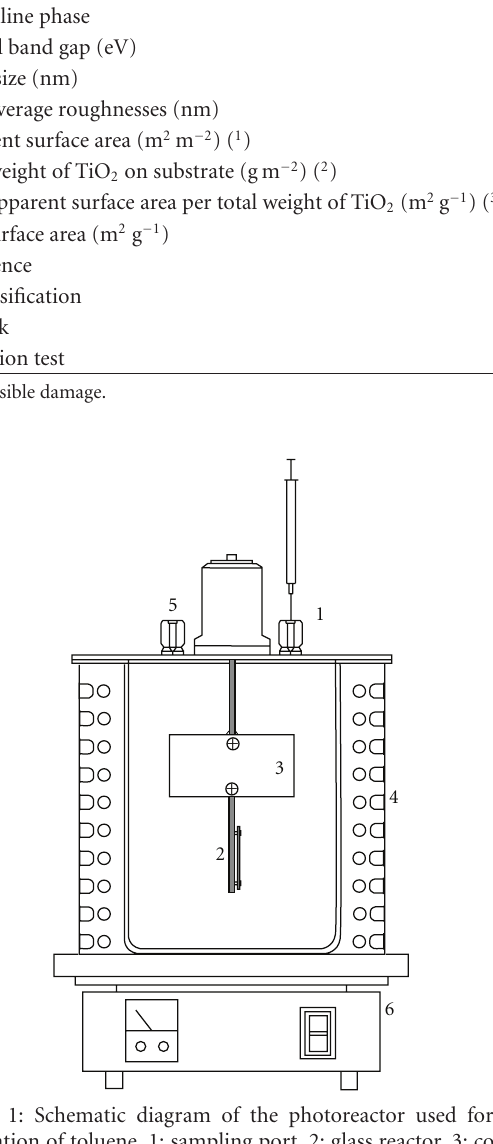
the light source, the degradation e ffi ciencies and kinetics of toluene in the photocatalytic process in a batch reactor are